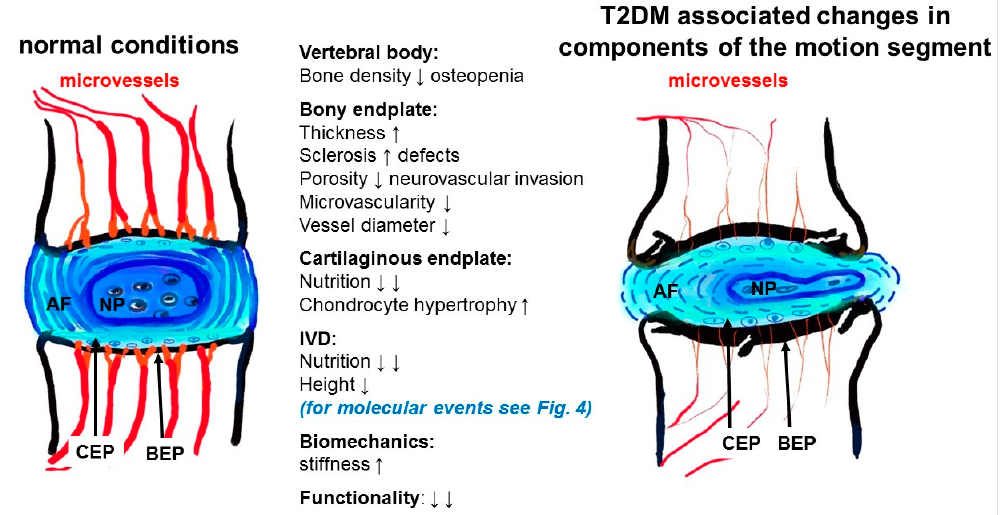
Figure 3. Summary of pathological T2DM-associated changes in components of the motion segment.